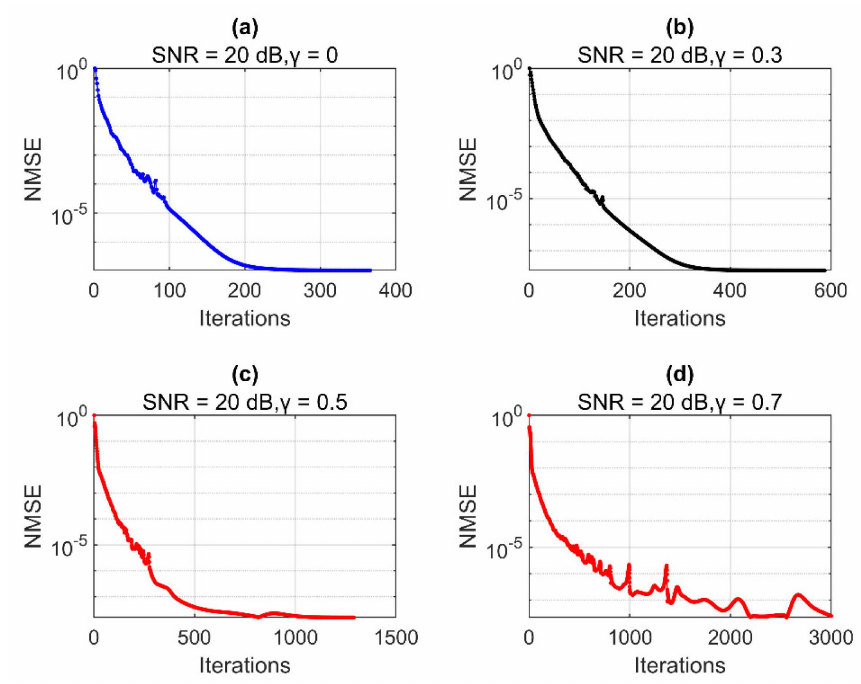
Figure 7. Relative error vs. Iteration using the proposed method for different values of γ with R = 4,